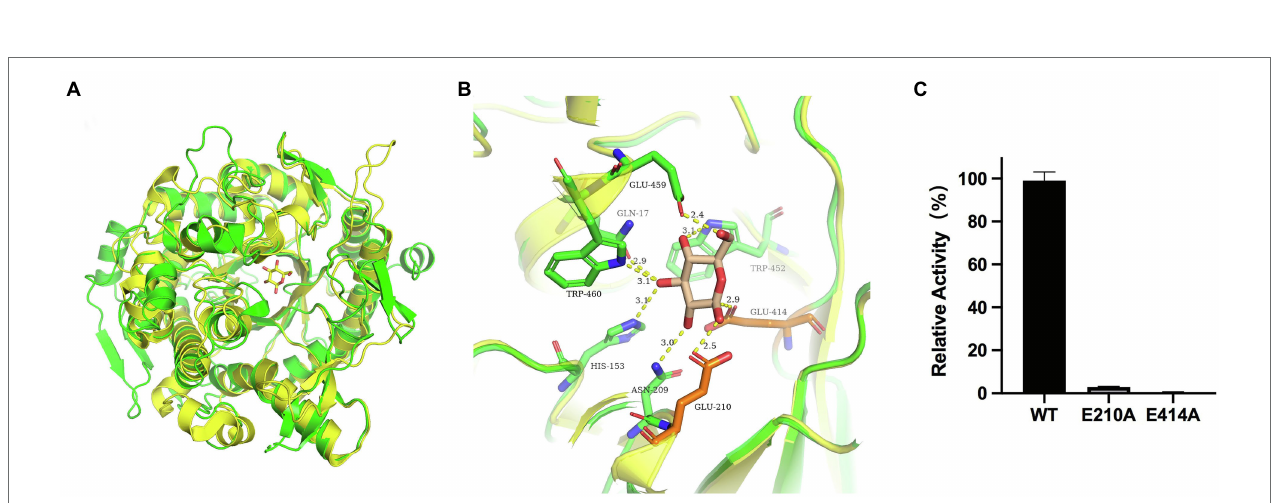
FIGURE 5 | Structure of the TsBGL active site. (A) The overall structure of TsBGL adopts a typical ( β / α ) 8 TIM-barrel fold. The side chains of the two important glutamates in the active-site of TsBGL are shown as stick models. (B) The active site regions of TsBGL. (C) The closest distance between the catalytic residues (O ε 2 atom of Glu210 and O ε 1 atom of